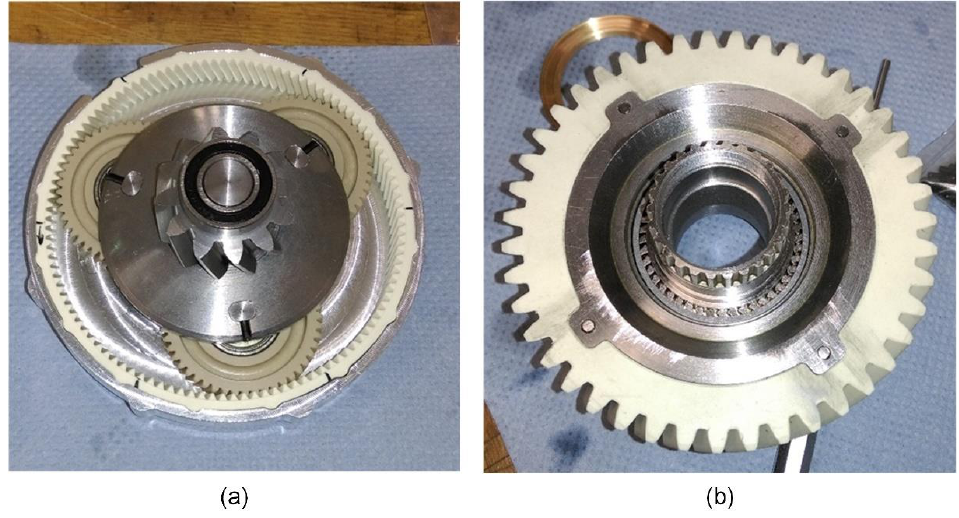
Figure 9. Polymer gears: ( a ) 1st stage—planetary gear; ( b ) 2nd stage—driven gear.